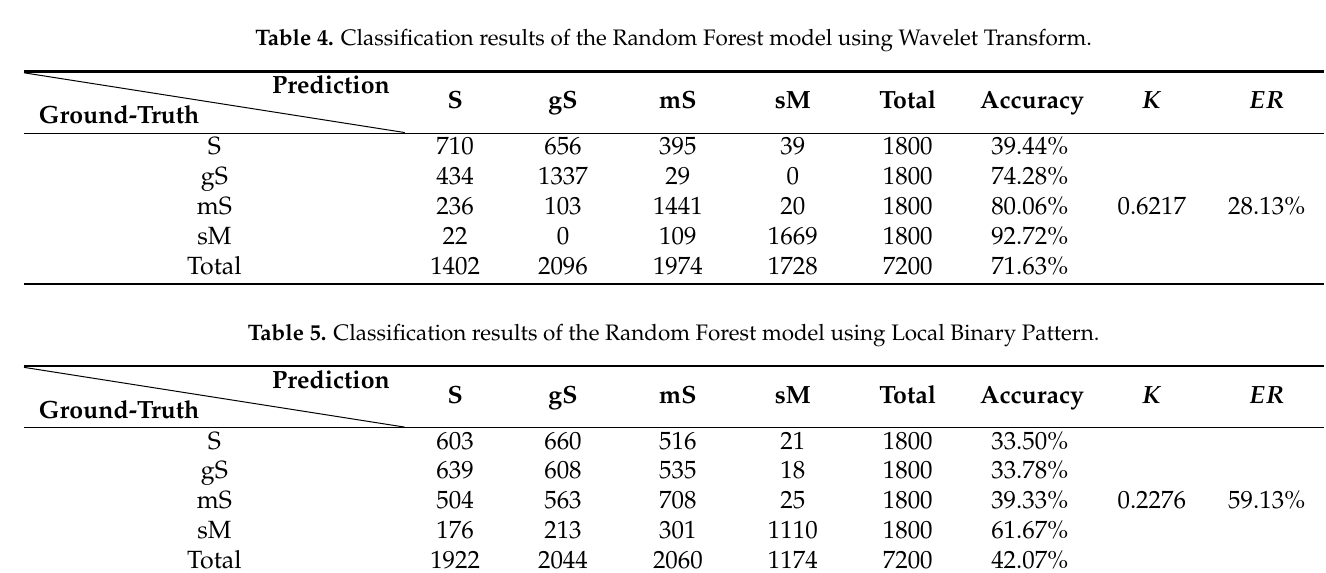
Table 6. Classification results of the Random Forest model using the Weyl Transform. Ground-Truth